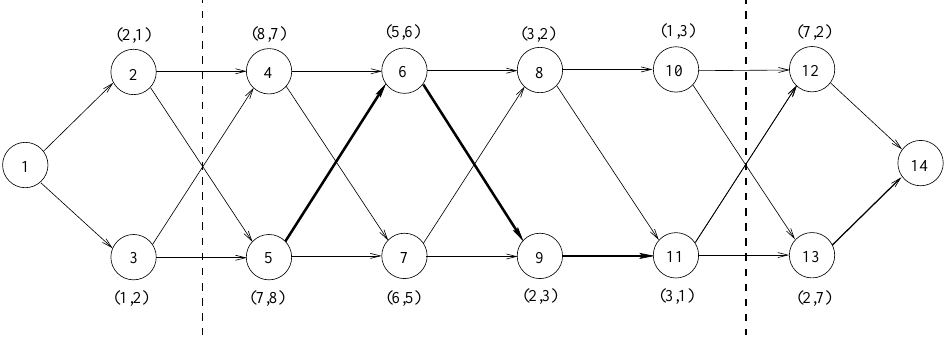
Figure 4: The layered graph L 4 ∗ of the transformed solution sequence S 4 ∗ . The path indicated by the bold edges, between vertices 5 and 11 , represents the same path as the path between vertices 4 and 10 in Figure